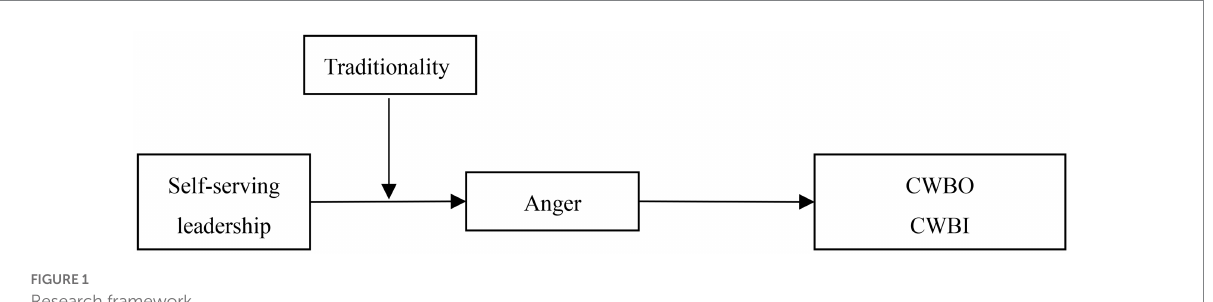
FIGURE 1 Research